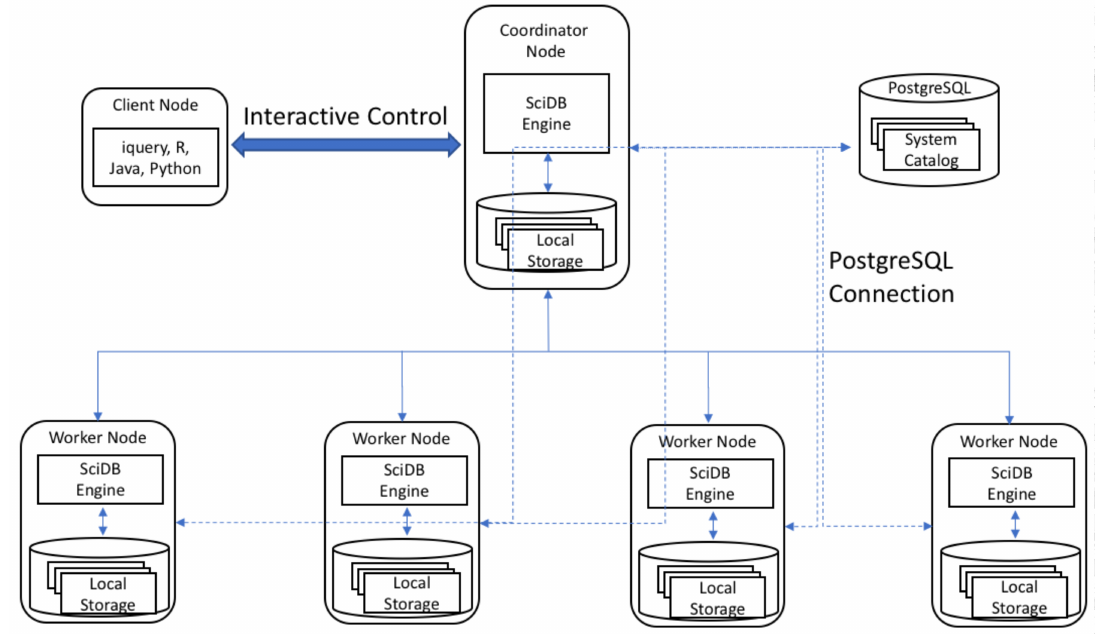
Figure 5. The architecture of